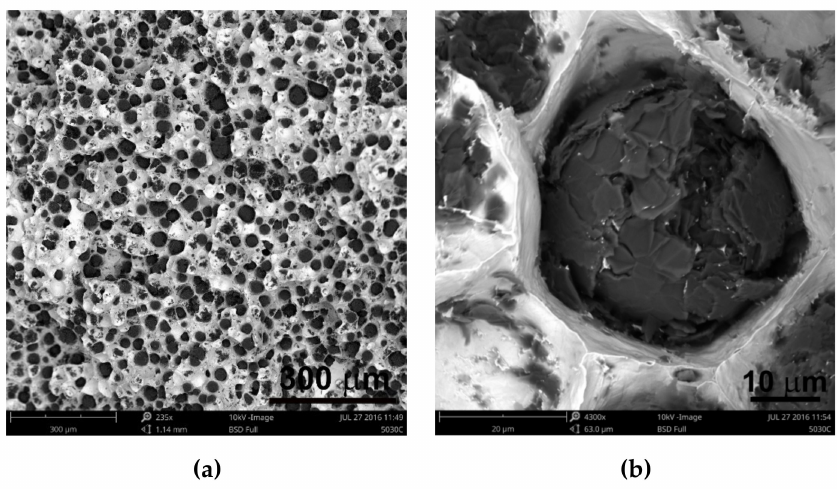
Figure 7. Images of sample fractures 5 magnification 235 × (a) and 4300 × ( b